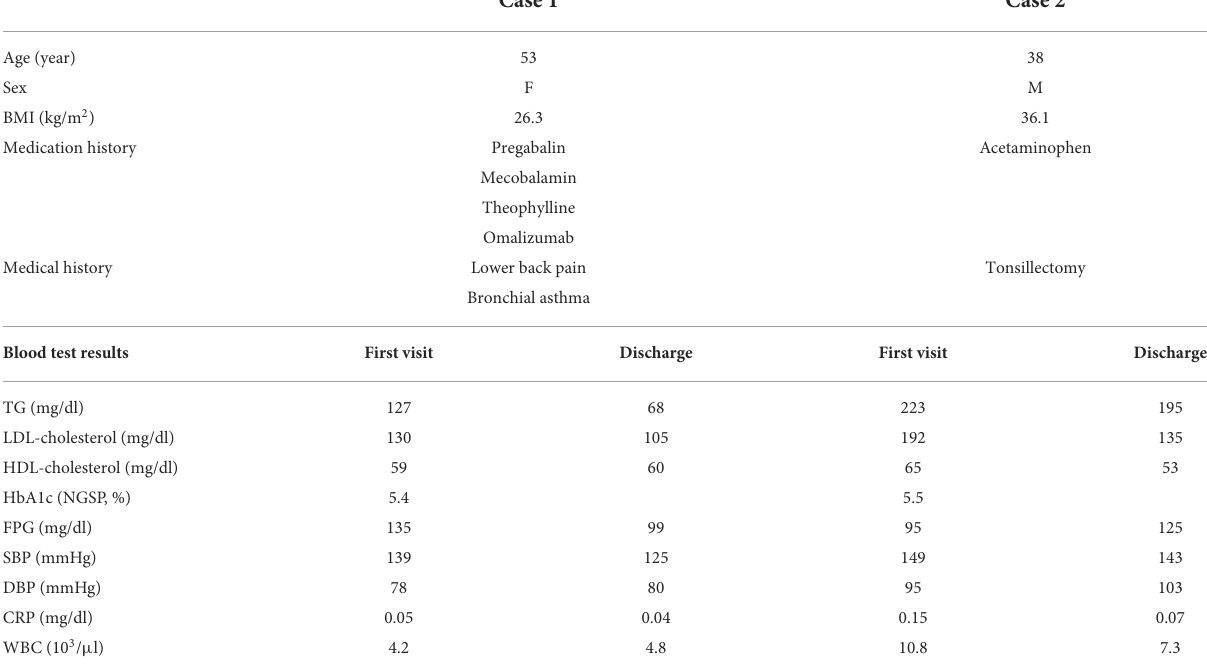
TABLE 1 Demographic and clinical characteristics of cases 1 and